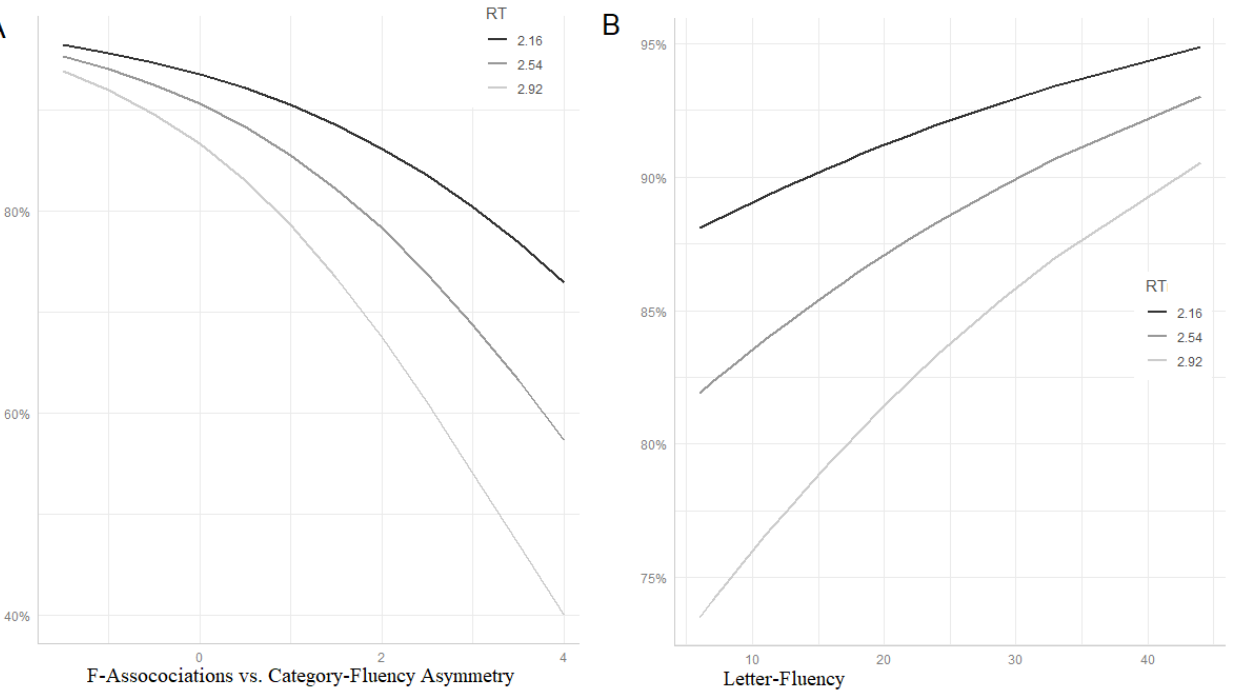
Figure 3. ( A ) Predicted probabilities of correct mPPT according to items’ reaction times in a healthy control group (mean ± SD) and F-associations vs. category-fluency asymmetry (mean ± SD). ( B ) Predicted probabilities of correct mPPT according to items’ reaction times and letter fluency.